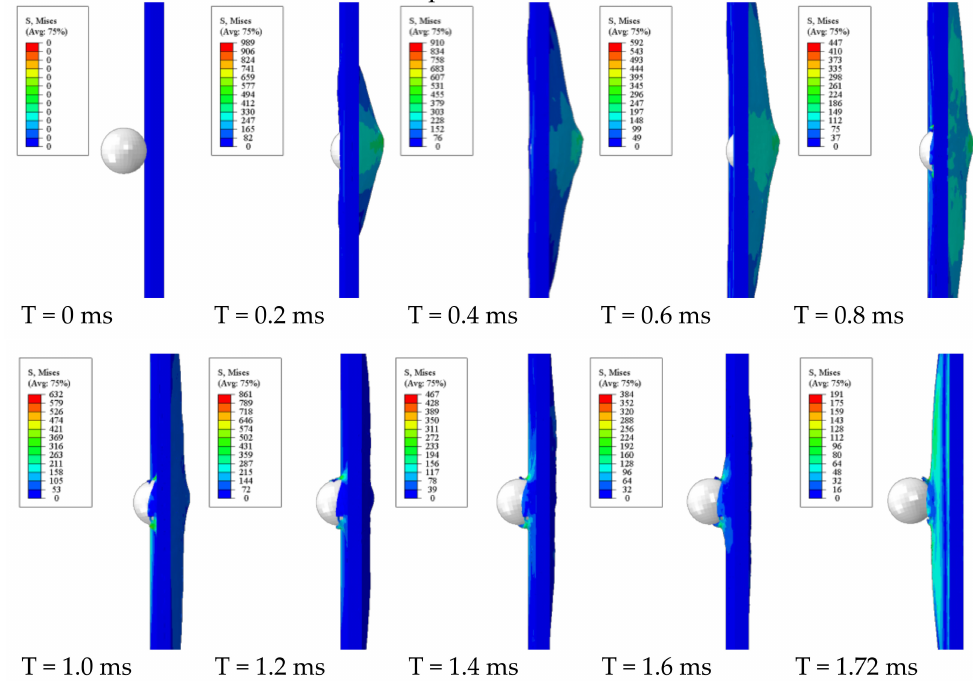
Figure 8. The physical process of the steel projectile impacting the GFRP laminate at a velocity of 150